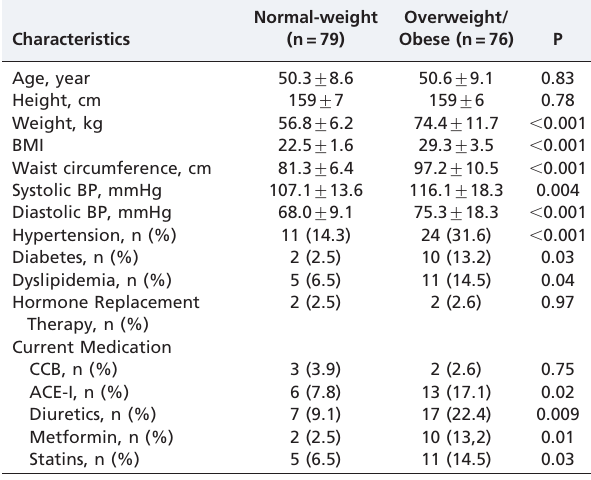
Table 1 - Demographic and clinical characteristics of the study